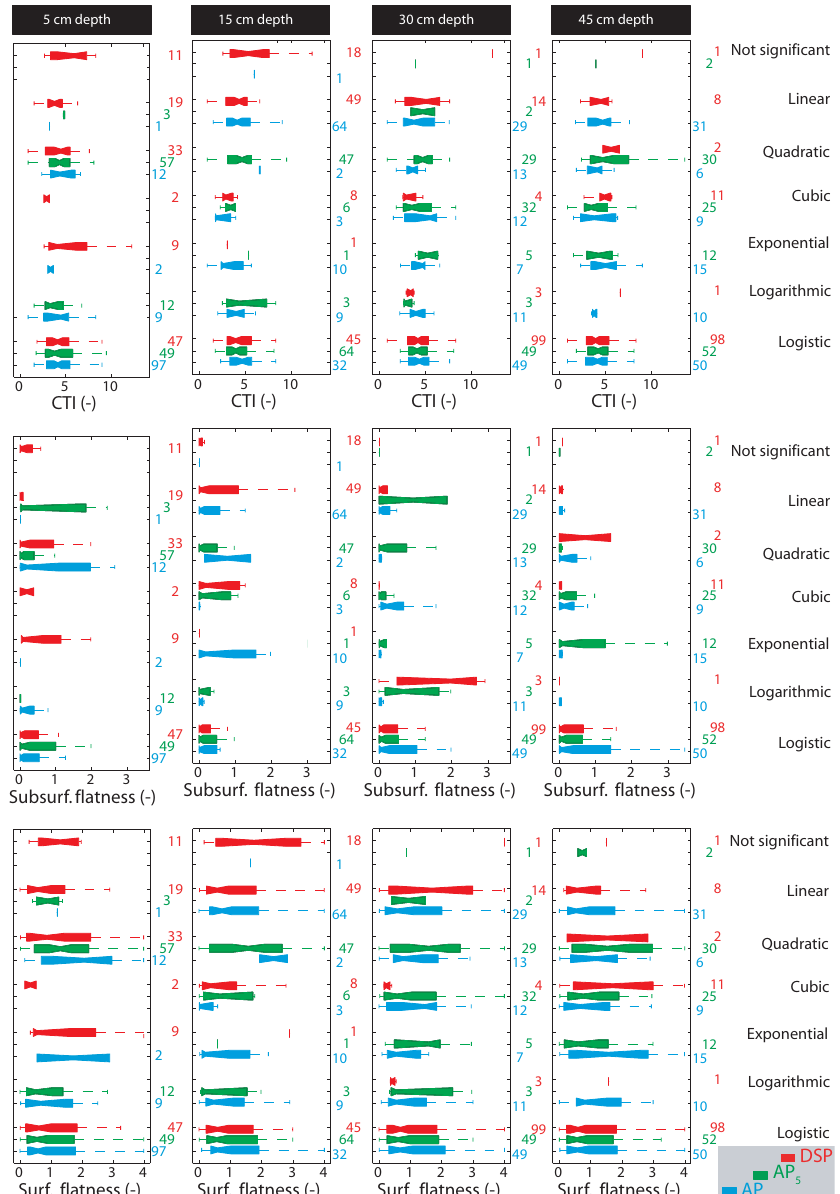
Fig. 9. Influence of various topographic properties (surface and subsurface multi-resolution valley bottom flatness and compound topographic index) on the nature of the relationship between point-scale soil moisture and selected surrogate measures for AMCs. Blue, green and red numbers illustrate the number of data used to plot each box of the same